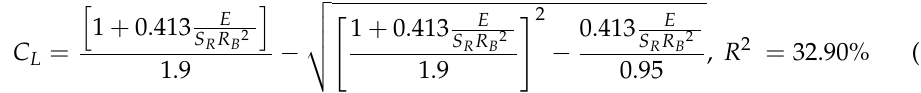
Table 7. Parameter estimation of the Euler buckling coefficient ( K bE ).